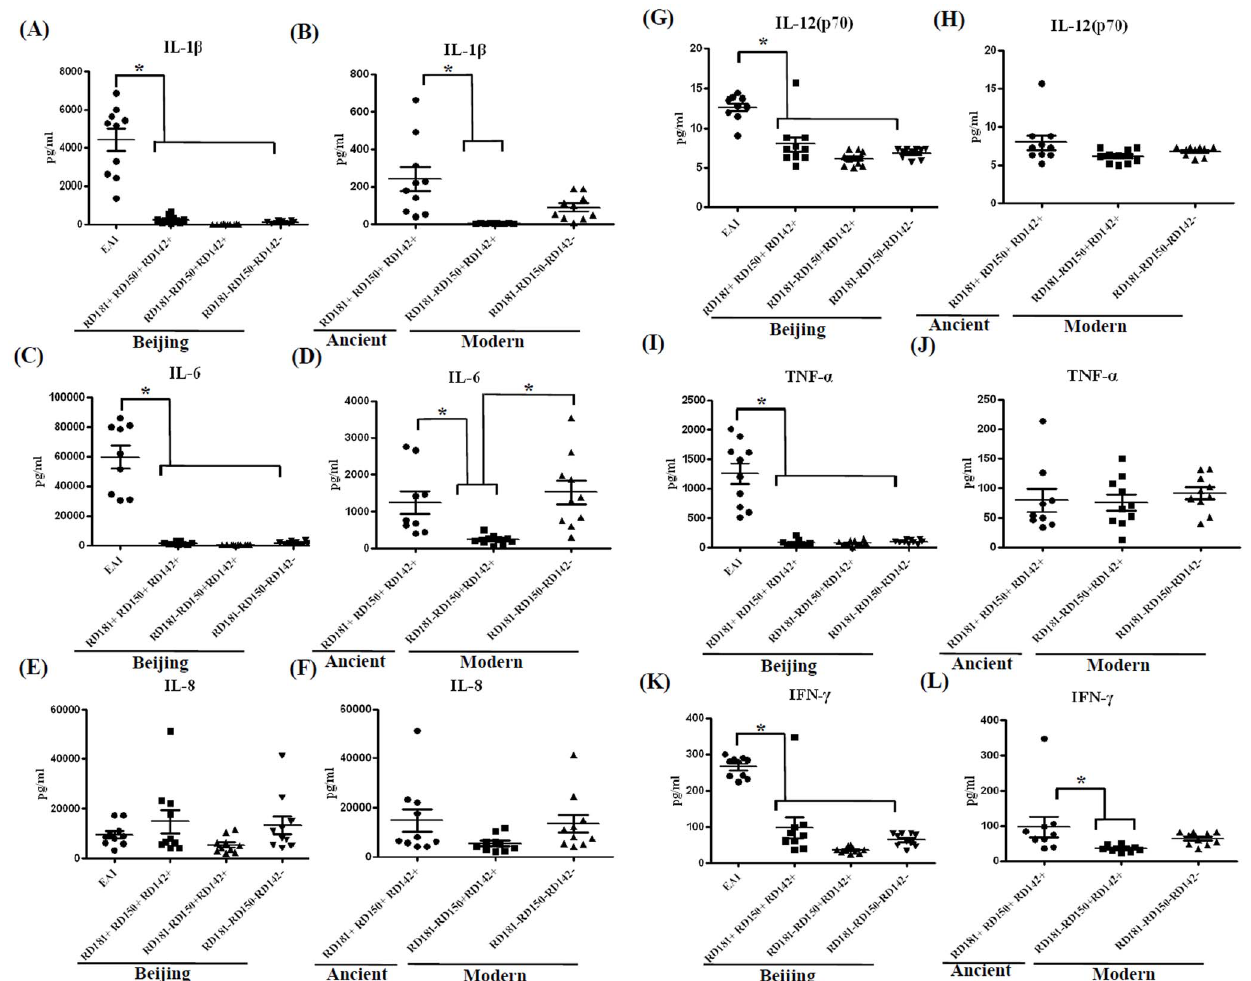
Figure 1. Pro-inflammatory cytokine production varies with genetic clustering of MTB lineages. Ten strains of each sub-lineage were selected for further assays. Human MDM were infected with each MTB strain, respectively. The culture supernatants were collected and assayed as described in methods. *, indicating P , 0.05. doi:10.1371/journal.pone.0094296.g001 PLOS ONE |